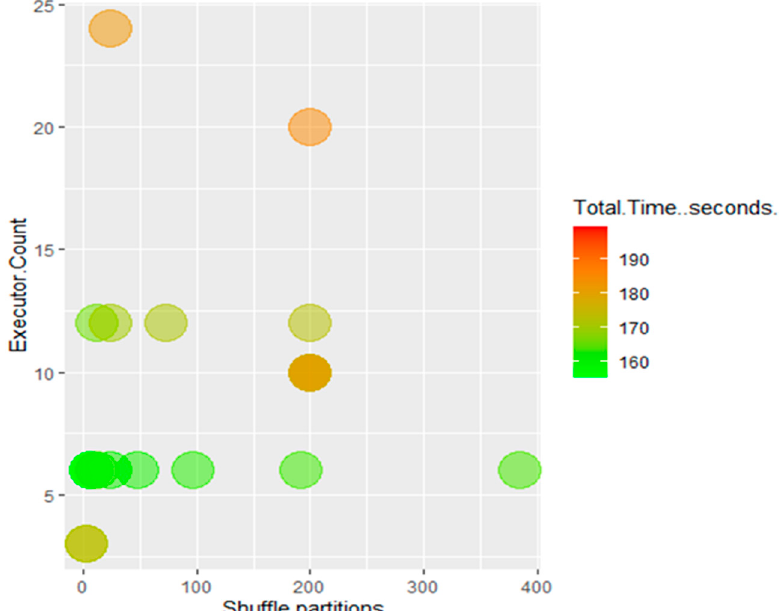
Figure 10. Processing times as a function of executor count and shuffle partitions, Time ≤ 200 s.